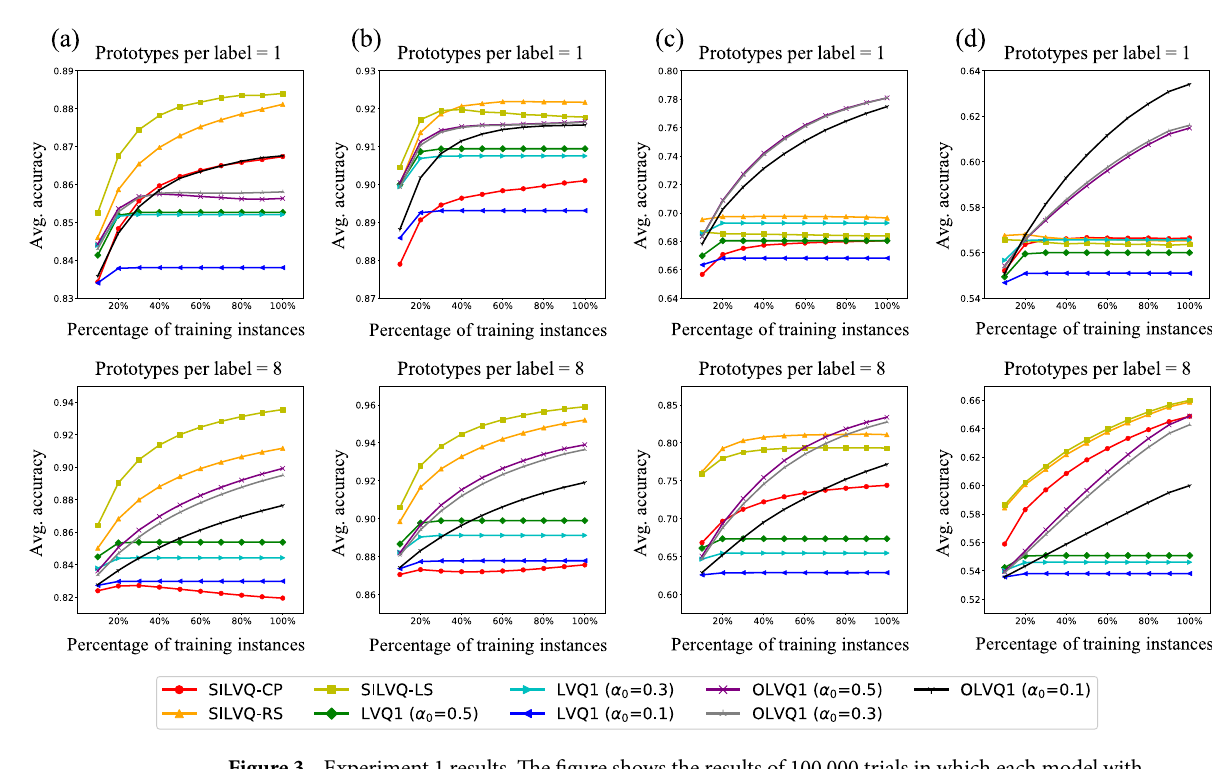
Figure 3. Experiment 1 results. The figure shows the results of 100,000 trials in which each model with prototypes per label = 1 and 8 trained with each dataset 1 time. Each graph shows the average accuracy at each training stage. ( a ) Results for the Glass dataset. ( b ) Results for the Iris dataset. ( c ) Results for the Ionosphere dataset. ( d ) Results for the Sonar